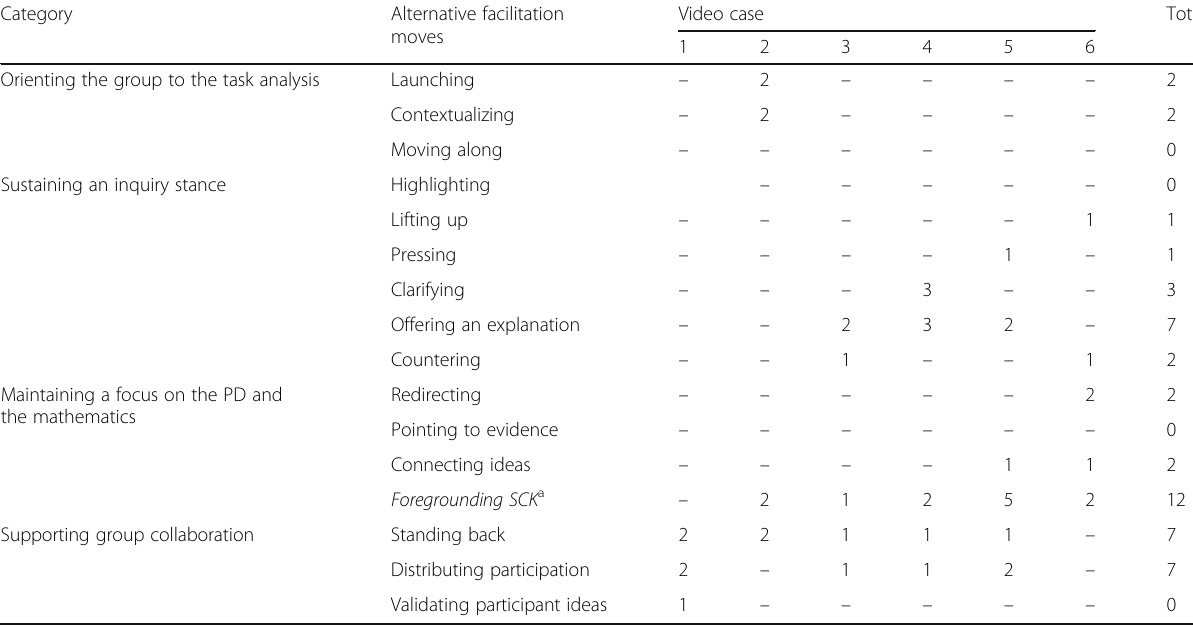
Table 7 Suggested alternative facilitation moves, benefiting teacher learning in PD